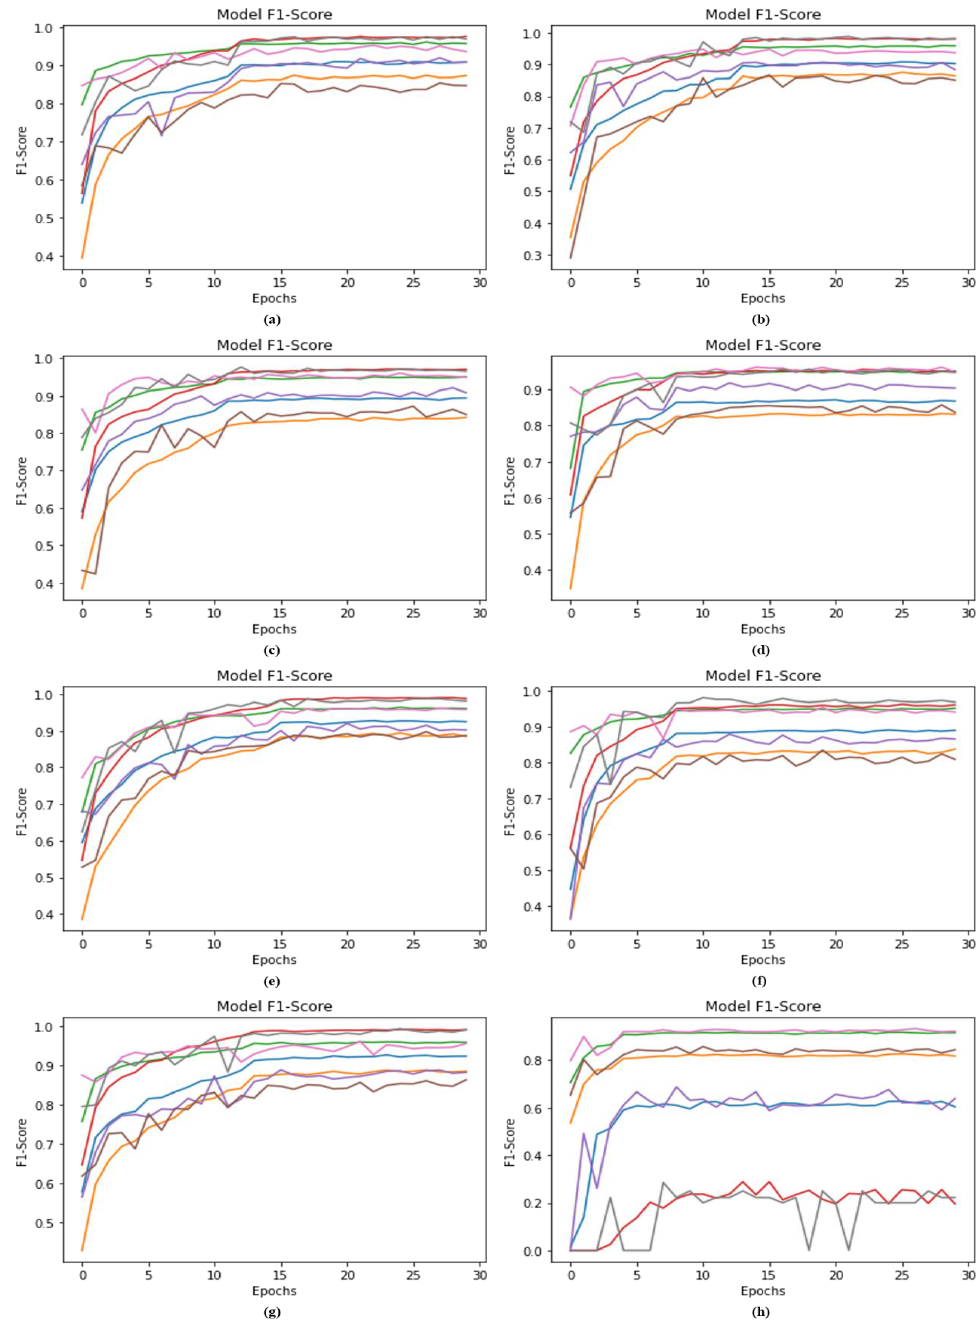
Figure 10. The value of the F1-score between the proposed model and six baseline models; ( a ) Vgg-16, ( b ) Vgg-19, ( c ) EfficientNet-B0, ( d ) ResNet-152, ( e ) Inception-V3, ( f ) MobileNet, ( g ) Proposed Model with SMOTE Tomek, and ( h ) Proposed Model without SMOTE Tomek.